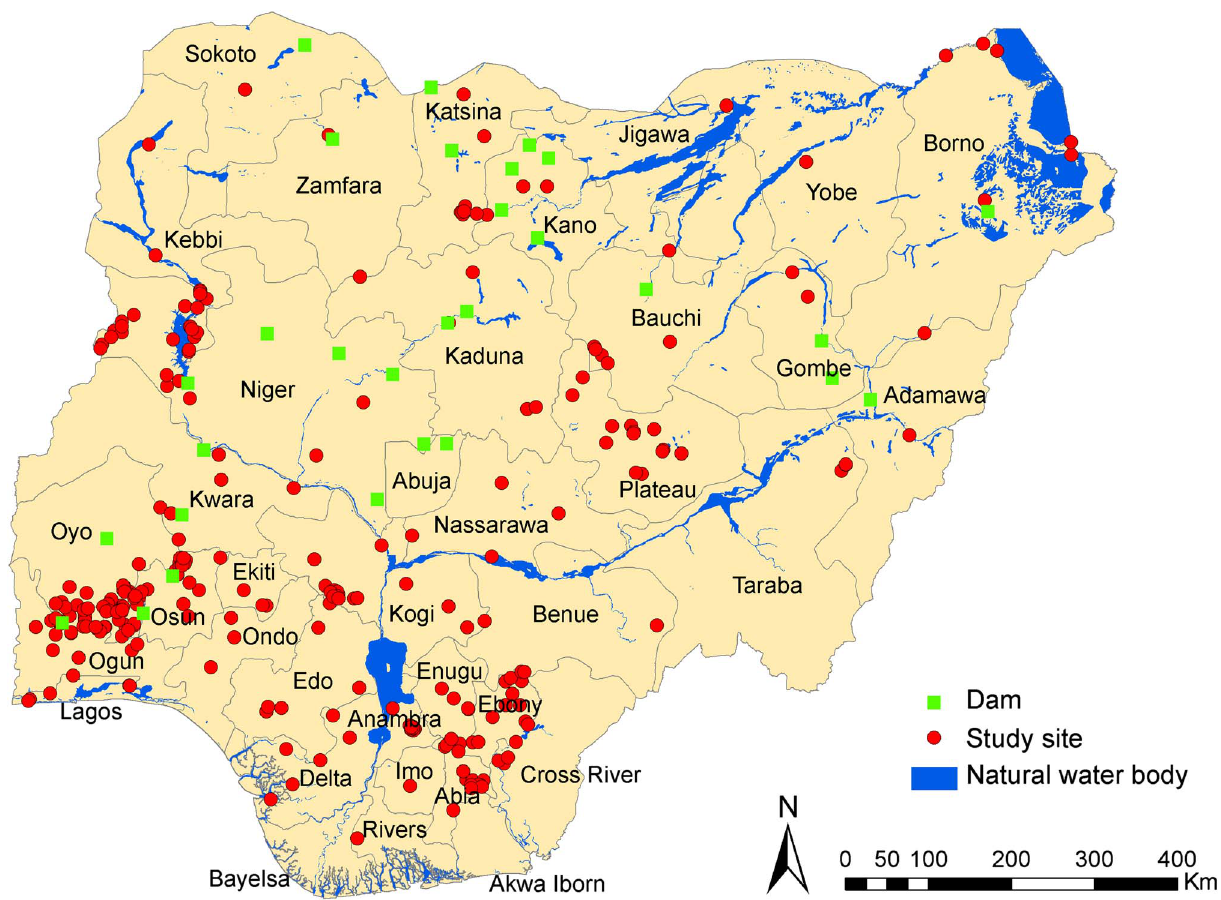
Figure 3. Map of Nigeria, showing location of study sites, dams, and natural water